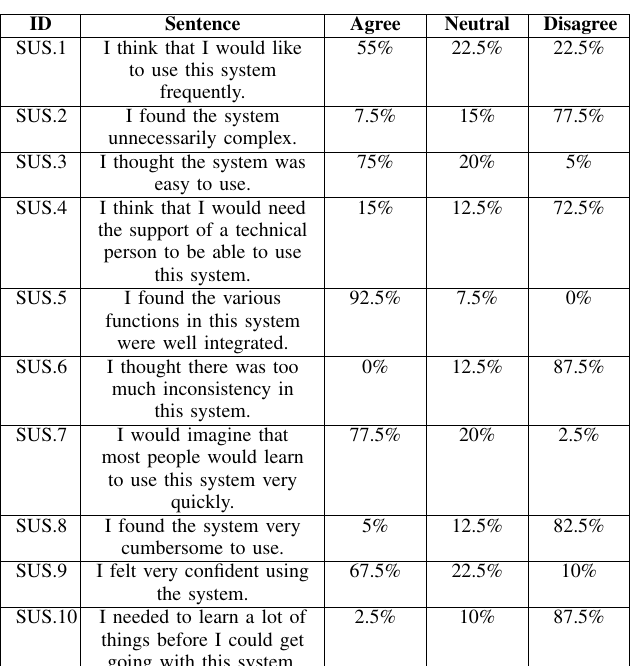
Table III R ESULTS FROM THE SUS QUESTIONNAIRE